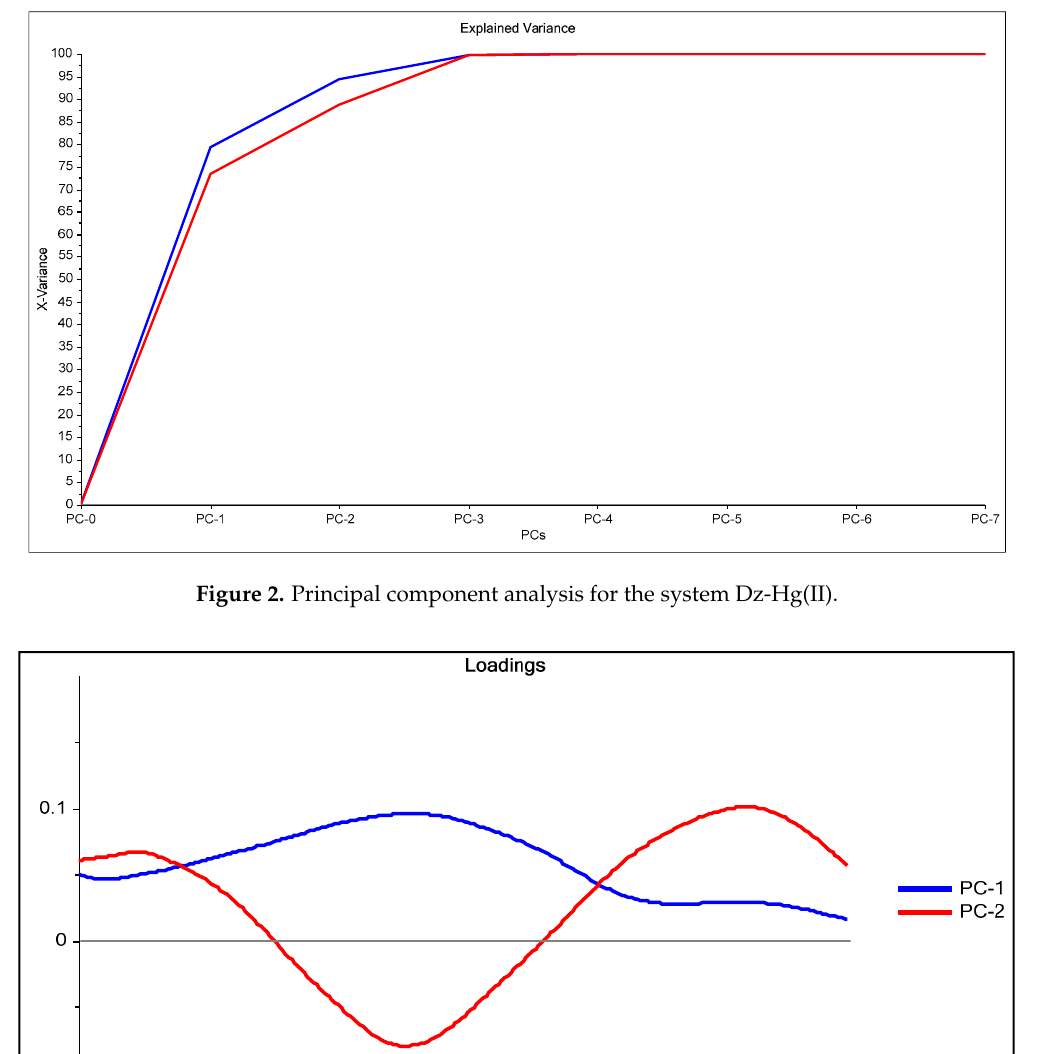
Figure 1. Visible spectra of the membranes after complexation for the system Dz-Hg(II).